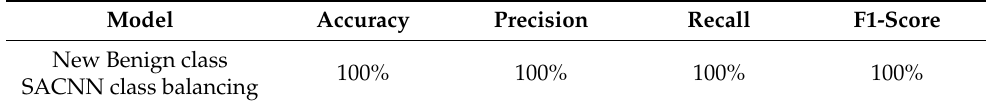
Table 3. Results of model with an extra benign